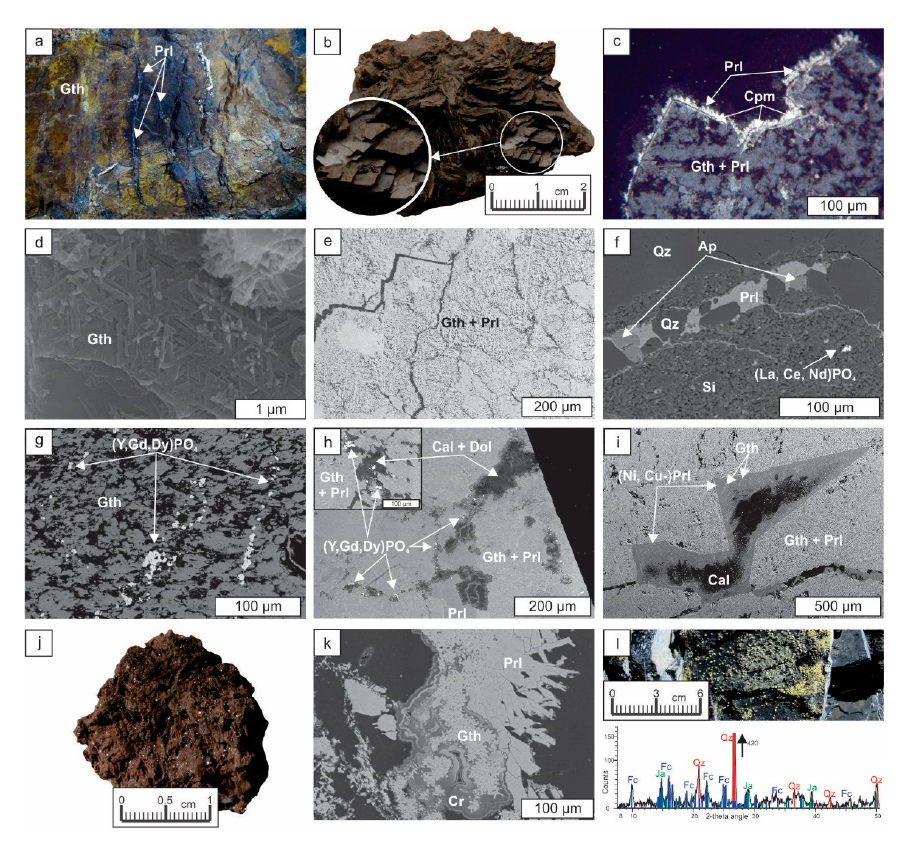
Figure 4. Fe-Mn mineralization ( c : reflected light photomicrograph; d – i , k : SEM photomicrographs, in backscattered electrons mode). ( a ) Pyrolusite (Prl) veins in iridescent goethite (Gth); ( b ) rhombohedral goethite; ( c ) acicular pyrolusite (Prl) and cryptomelane (Cpm) at the surface of goethite (Gth) intermixed with pyrolusite (Prl); ( d ) goethite (Gth) crystallites highlighting the pseudomorphose of siderite along cleavages; ( e ) cleavages of primary minerals preserved in the intermixed goethite (Gth) and pyrolusite (Prl); ( f ) apatite (Ap) and quartz (Qz) in a pyrolusite (Prl) vein cutting quartz (Qz) and unidentified silicates (Si), where a (La, Ce, Nd) phosphate is observed; ( g ) accumulation of (Y, Gd, Dy)PO 4 , in goethite (Gth); ( h ) (Y, Gd, Dy)PO 4 on the edges of calcite (Cal) and dolomite (Dol) crystals, close to pyrolusite (Prl), in the intermixed goethite (Gth) and pyrolusite (Prl); ( i ) calcite (Cal) observed as triangle-shaped sections of rhombohedrons, undergoing weathering and replacement by Ni- and Cu-rich pyrolusite ((Ni, Cu-)Prl) and goethite (Gth), in the intermixed goethite (Gth) and pyrolusite (Prl); ( j ) goethite with collomorph structures; ( k ) pyrolusite (Prl), goethite (Gth), and cryptomelane (Cr) growing in a cavity and forming collomorph structures; ( l ) yellowish jarosite (Ja) and ferricopiapite (Fc) (with X-Ray diffraction pattern) coating the Paleozoic schisteous host rock.